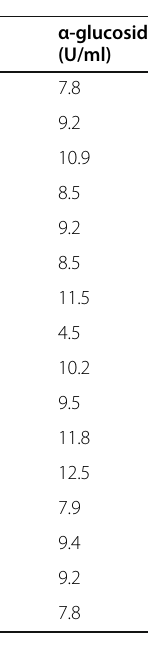
Table 2 L-16 Orthogonal array of Taguchi experimental design for α -glucosidase production from protonemal biomass of H.